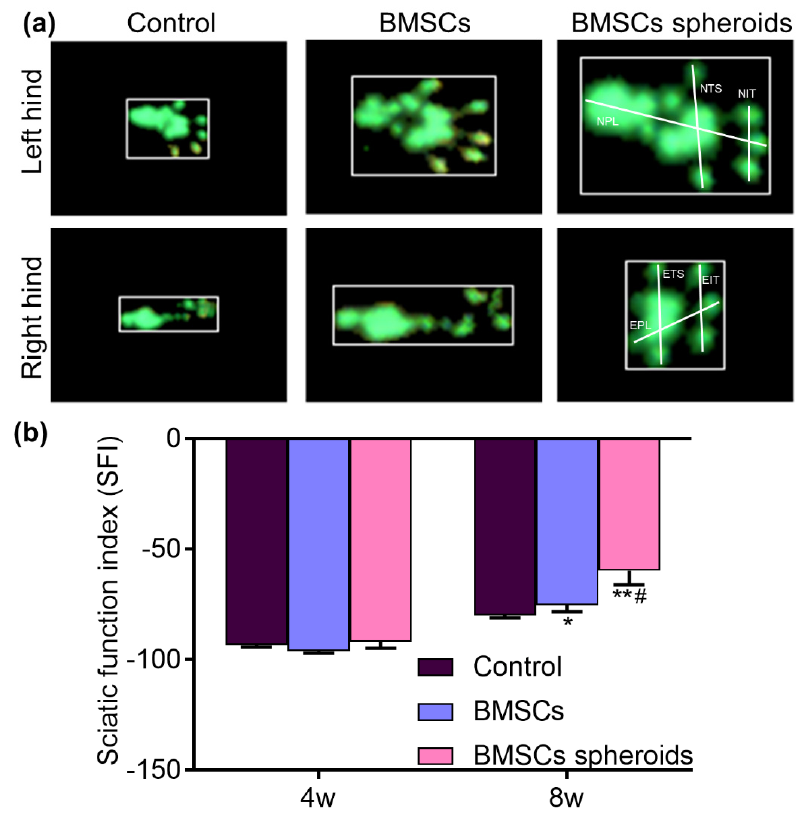
Figure 10. Motor function 4 weeks and 8 weeks after surgery. ( a ) Representative footprints images of right (injured) hind and left (normal) hind paw at 8 weeks after operation. ( b ) The sciatic